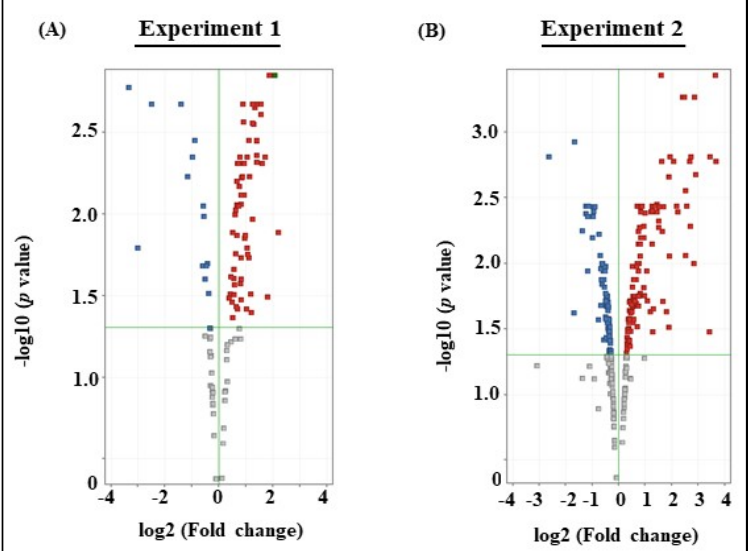
Figure 1. Volcano plot illustrated differentially expressed genes (DEGs) in milk extracellular vesicles (EVs) from BLV-infected cattle with high proviral load (HPL) and uninfected cattle in Experiment 1 ( A ) and BLV-infected cattle with HPL + high lactate dehydrogenase 2 + 3 (HLDH) and uninfected cattle with low LDH (LLDH) in Experiment 2 ( B ). The up-regulated genes were indicated in red and down-regulated genes were in blue. The fold change (in log 2 scale) of genes abundance was plotted on the x-axis, with statistical significance expressed as -log 10 [false discovery rate (FDR)] on the y-axis. Genes not classified as DEGs were plotted in gray.